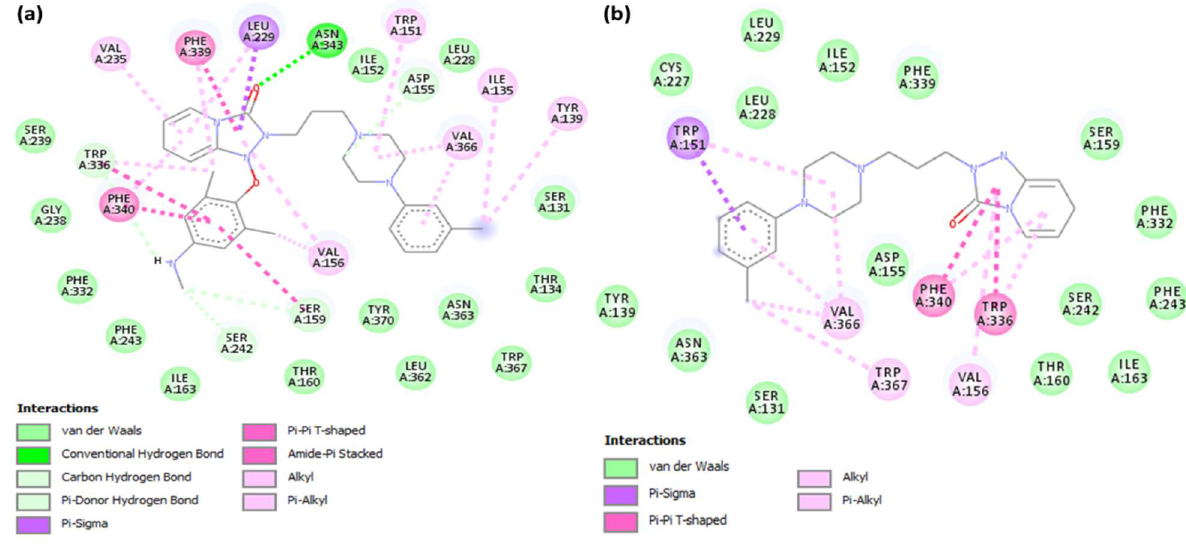
Figure 10. 3D structure of interactions between serotonin docked with ( a ) [(TZD)(DCQ)] or ( b ) TZD drug alone.